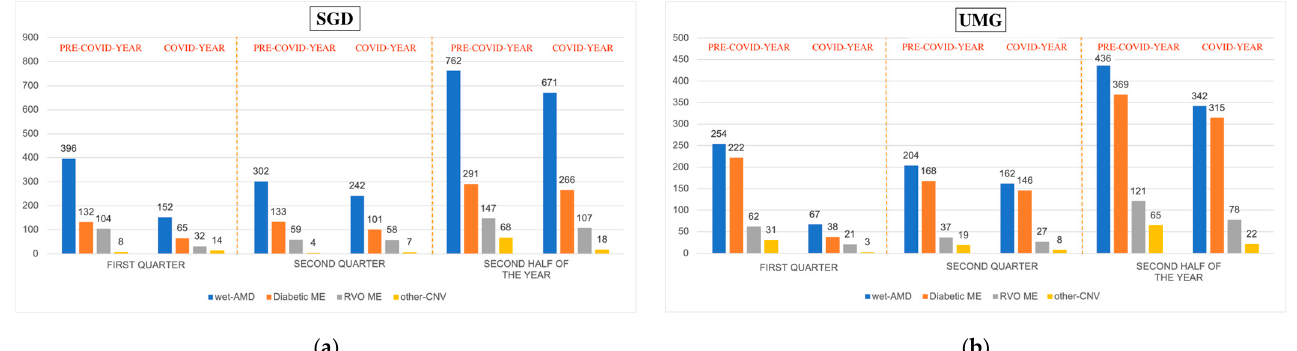
Figure 2. The change in the number of intravitreal injections divided into 4 categories: wet ‐ AMD (blue), diabetic ME (orange), RVO ME (grey), and other ‐ CNV (yellow) performed at San Giovanni di Dio (SGD), University of Cagliari ( a ) and Mater Domini, University Magna Græcia of Catanzaro (UMG) ( b ), in each study period.